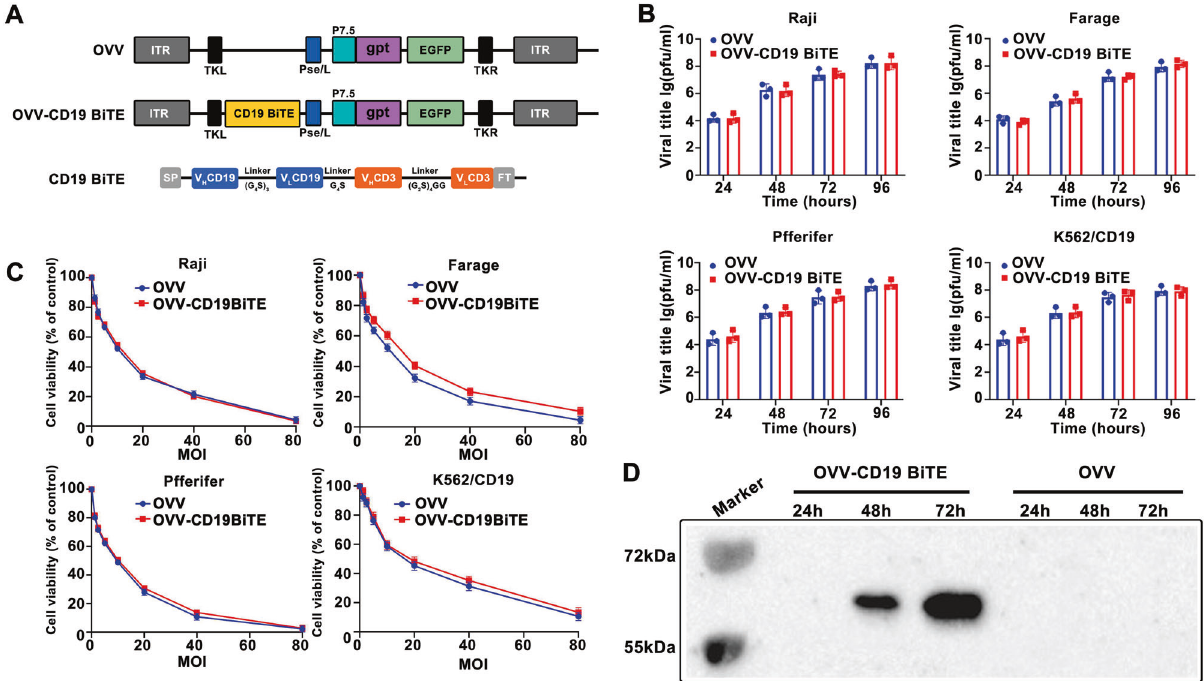
Fig. 1 Generation of a CD19BiTE-expressing oncolytic vaccinia virus and its oncolytic properties in vitro. A Schematic structure representation of OVV-CD19BiTE. VL and VH domains of anti-CD19 and CD3 Ɛ are connected by glycine and serine fl exible linkers, fl anked by the light chain immunoglobulin signal peptide (SP) and the FLAG tag (FT). CD19BiTE is inserted into the vaccinia virus TK gene under the control of the promoter Pse/l. TKR right fl ank sequences of thymidine kinase gene, TKL left fl ank sequences of thymidine kinase gene, gpt guanine phosphoribosyl transferase, EGFP enhanced green fl uorescent protein, P7.5k vaccinia virus P7.5k early/late promoter, Pse/l synthesized vaccinia virus early/later promoter. B Viral production of OVV-CD19BiTE. Tumor cell lines (Raji, Pffeifer, Farage, K562/CD19) was infected with OVV or OVV-CD19BiTE at MOI of 0.5. At indicated time points, cell extracts were harvested and titrated by an TCID50-based method. Data represent the mean ± standard deviation (SD) of three independent experiments. C Comparative cytotoxicity pro fi le of